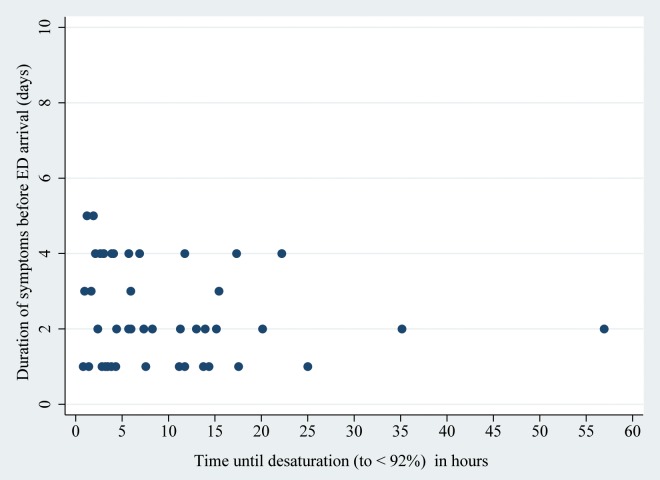
Correlation between duration of symptoms before Emergency Department (ED) arrival and time until desaturation (to < 92%) in patients < 3 months (n = 45).R2 = 0.02, P = 0.32.